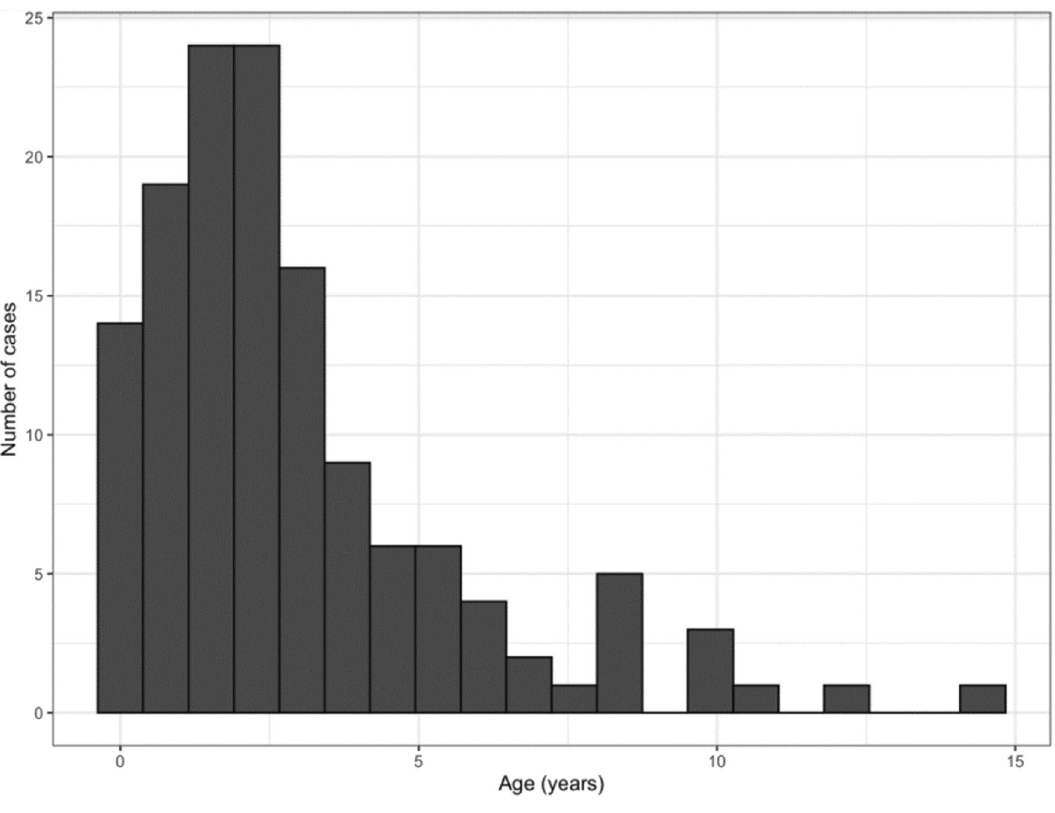
Figure 1. Age distribution of patients with